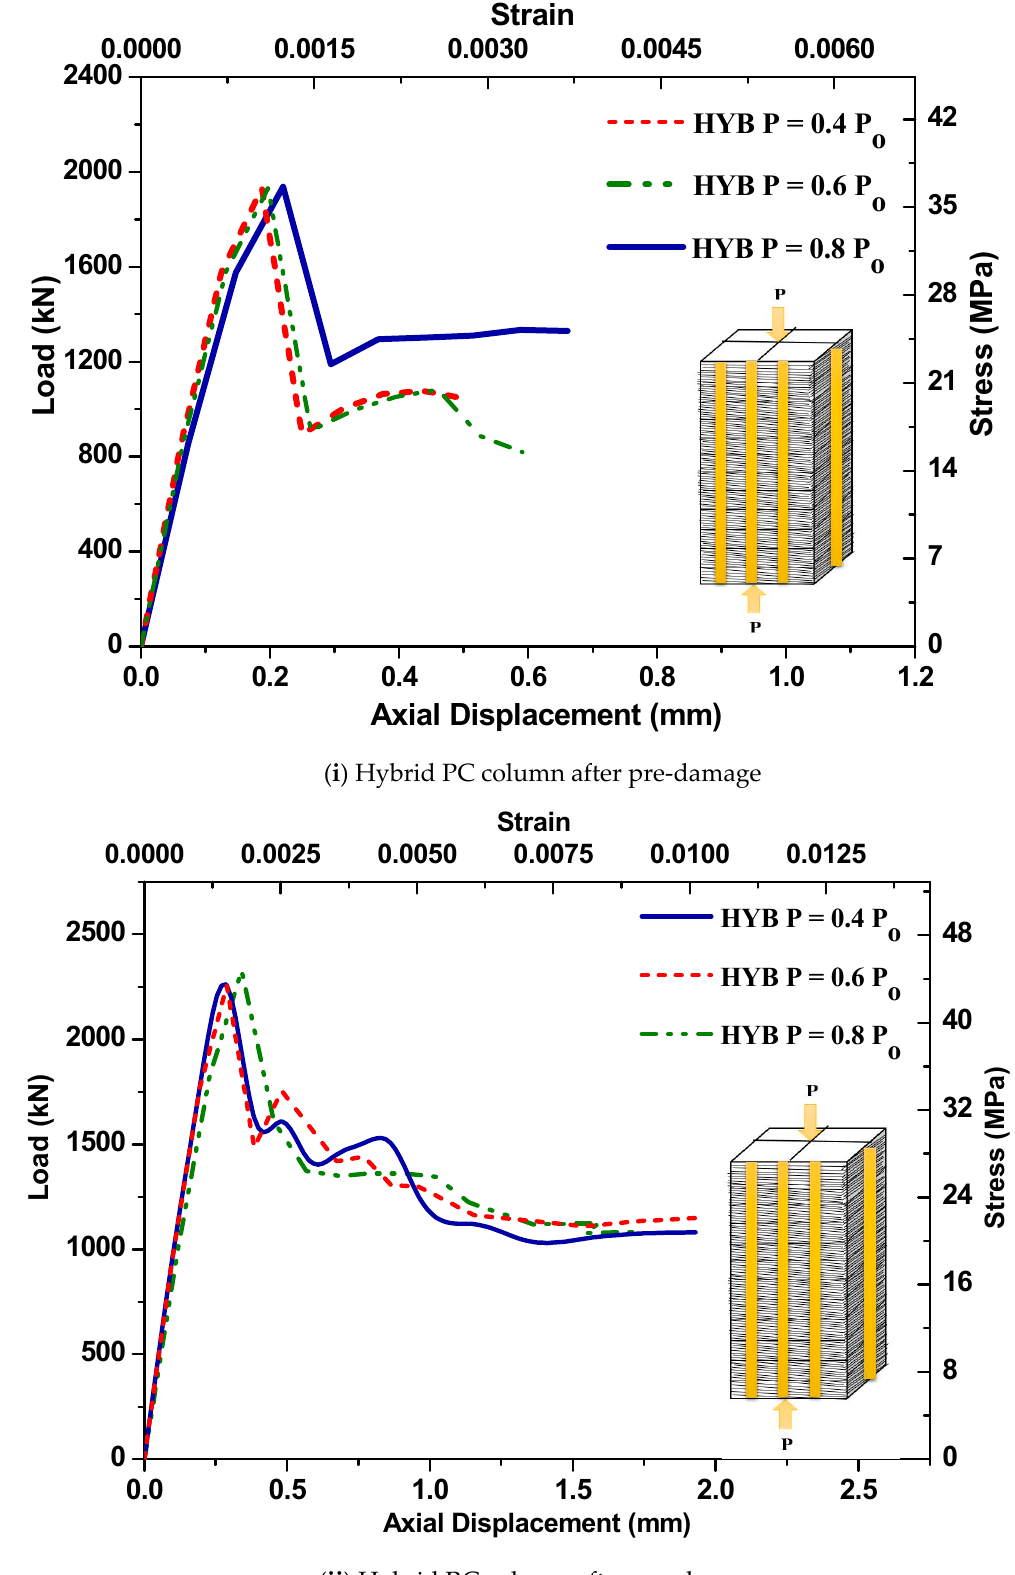
Figure 14. Effect of pre-damage levels on hybrid FRP strengthening. Figure 14. E ff ect of pre-damage levels on hybrid FRP